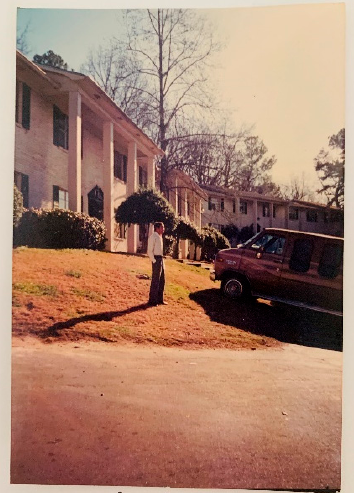
Figure 7. A day in my grandpa’s life in the U.S. in 1994.